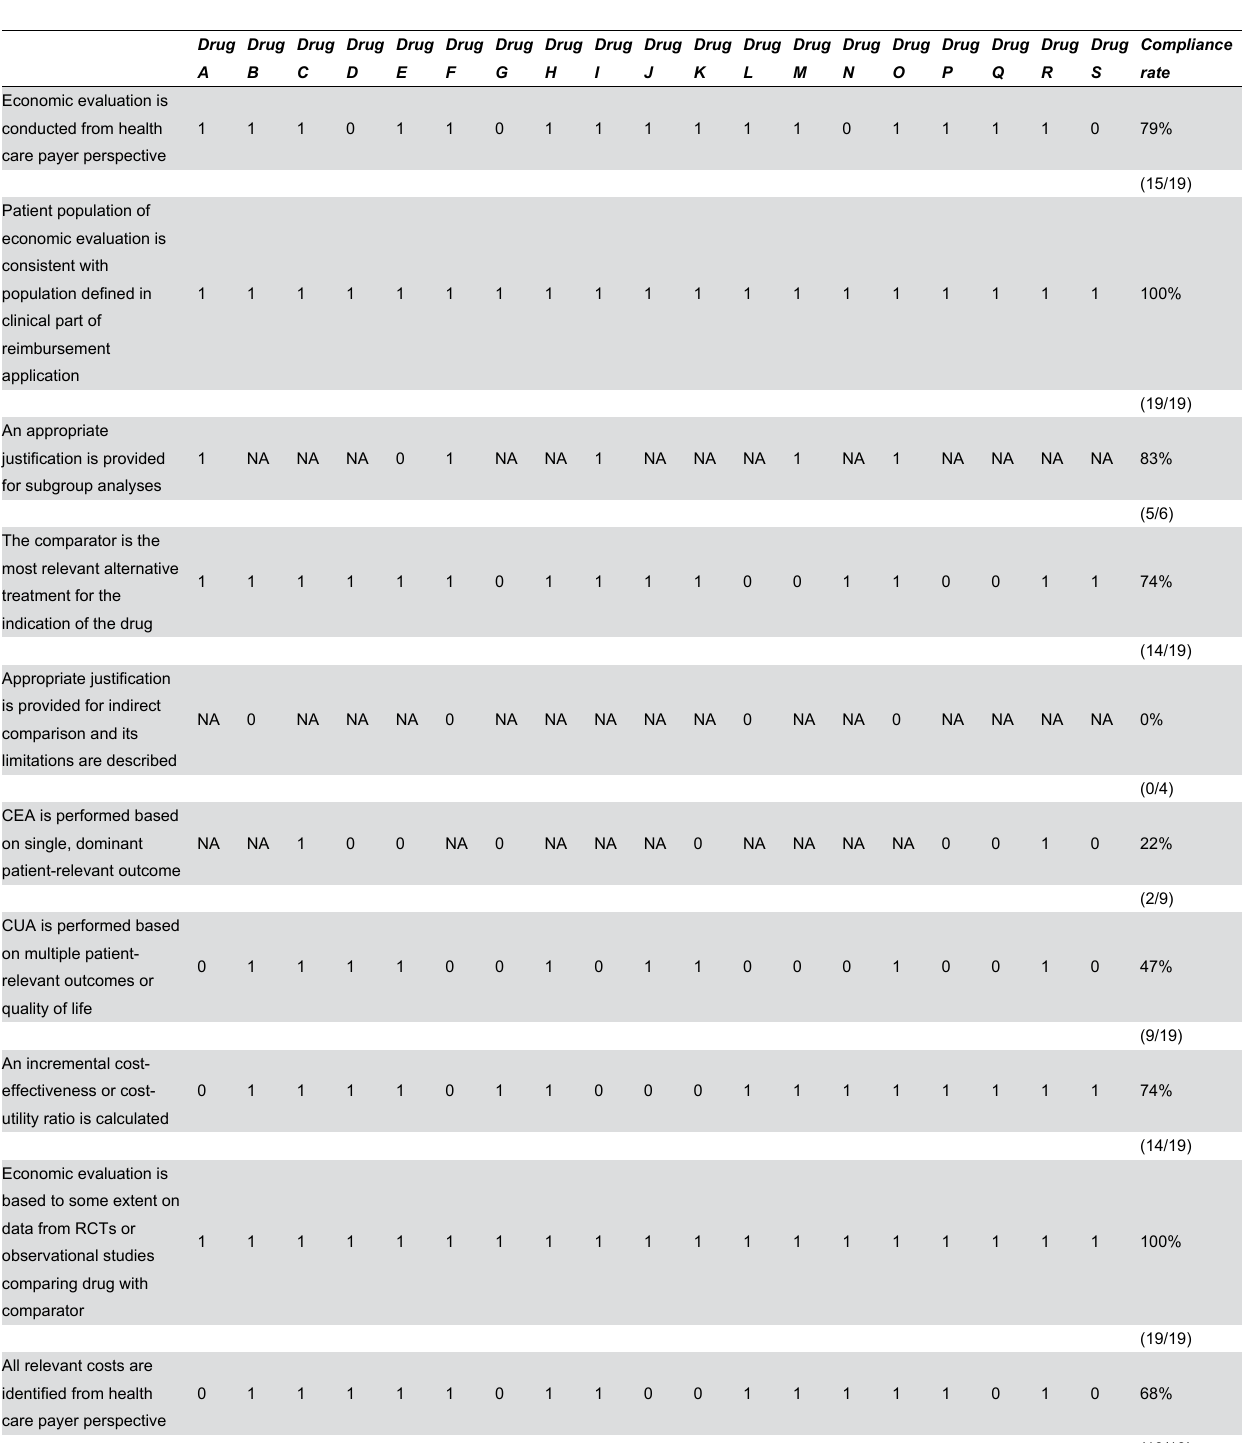
Table 1. Compliance of economic evaluations in Belgian drug reimbursement applications with KCE